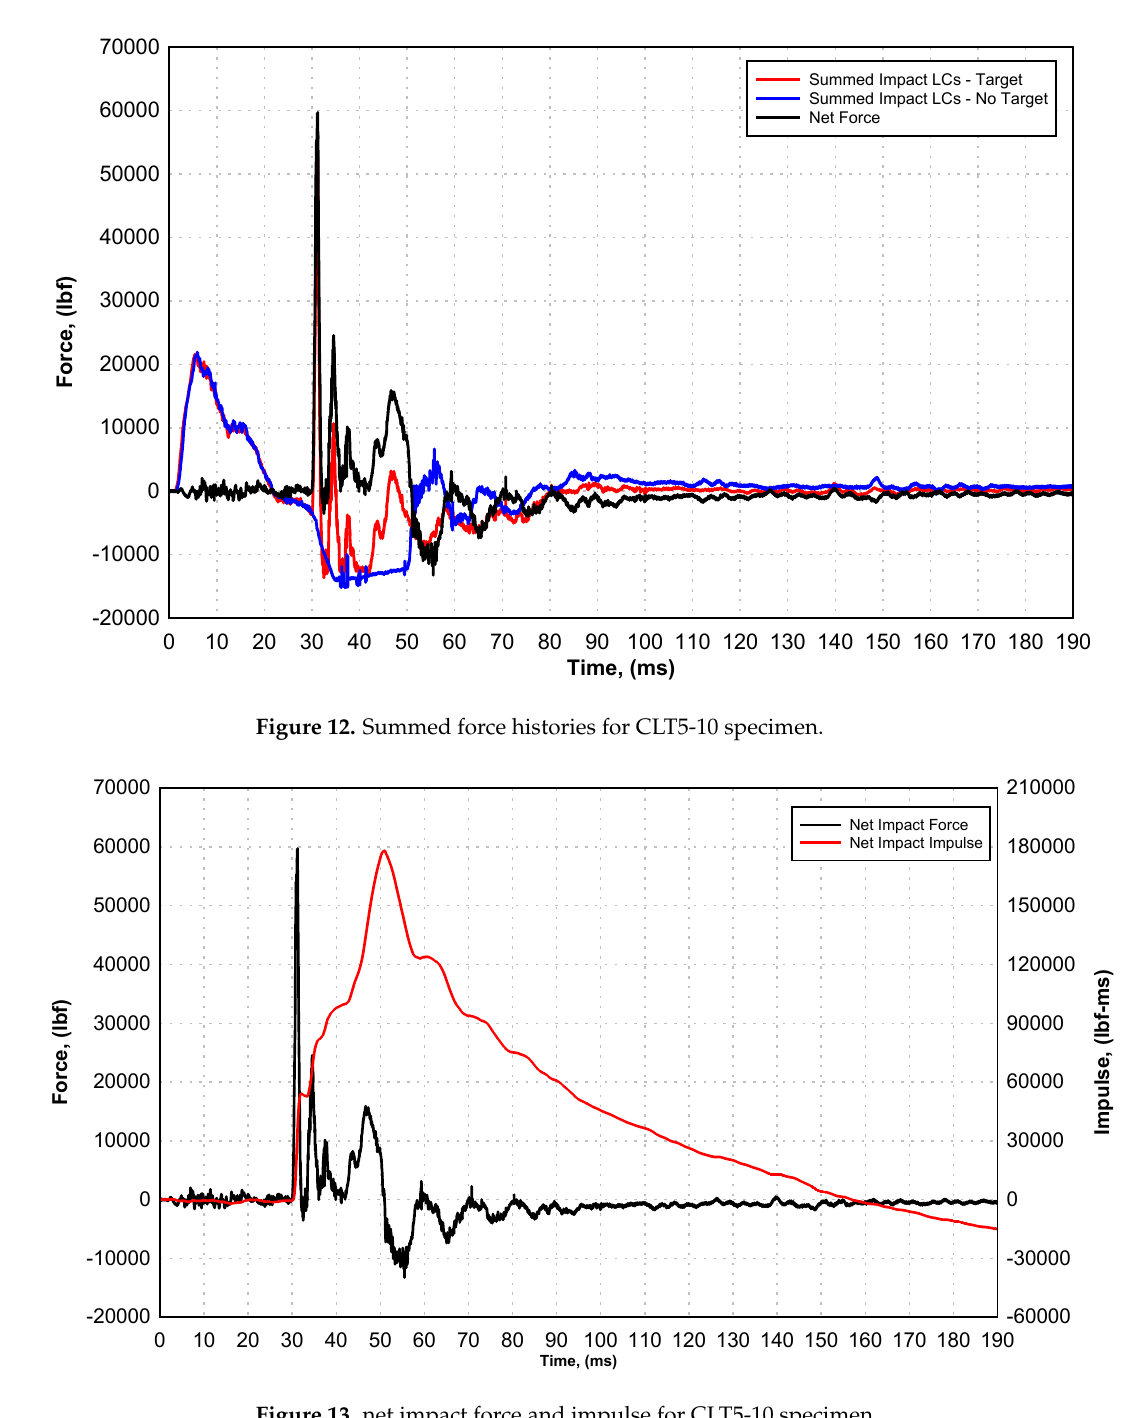
Figure 13. net impact force and impulse for CLT5-10